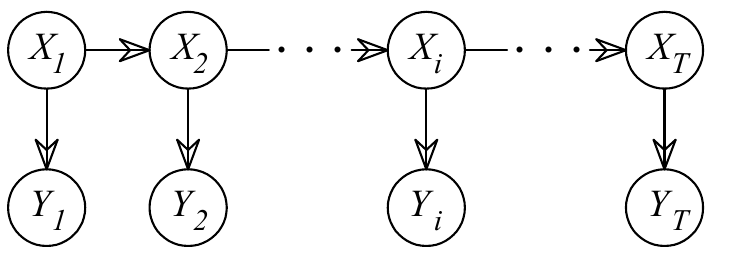
Figure 3. A Dynamic Bayesian Network.